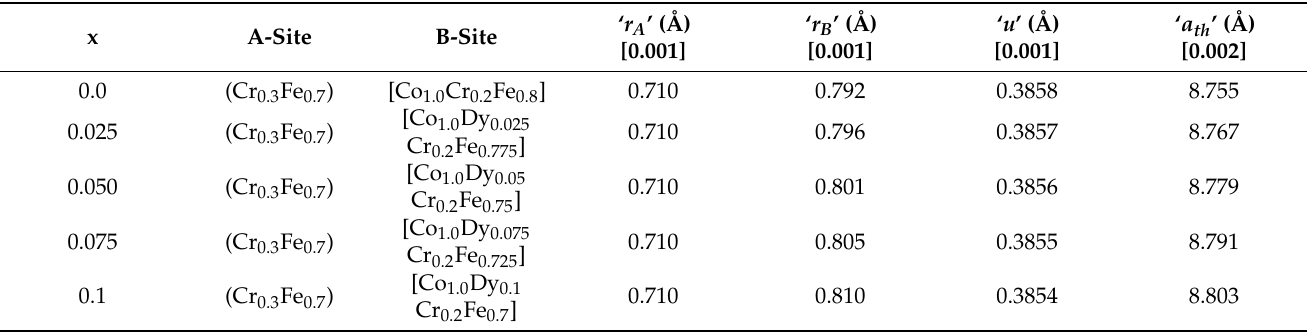
Table 3. Cation distribution of A- and B-sites, mean ionic radii ( r A and r B ), oxygen parameter ( u